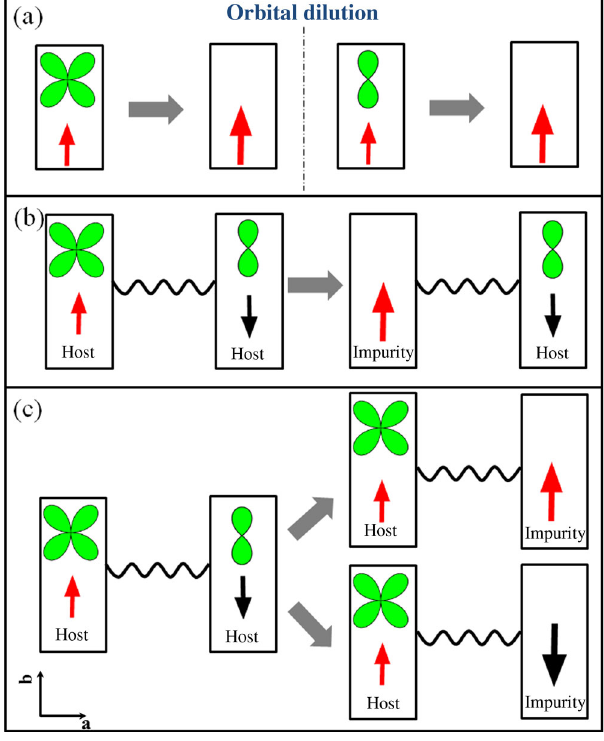
FIG. 1. (a) Schematic view of the orbital dilution when the 3 d 3 ion with no orbital degree of freedom and spin S ¼ 3 = 2 substitutes the 4 d 4 one with spin S ¼ 1 on a bond having specific spin and orbital character in the host (gray arrows). Spins are shown by red arrows, and doubly occupied t 2 orbitals (doublons) g are shown by green symbols for the a and c orbitals, respectively. (b) If an inactive orbital along the bond is removed by doping, the total spin exchange is AF. (c) On the contrary, active orbitals at the host site can lead to either FM (top) or AF (bottom) exchange coupling, depending on the energy-level mismatch and difference in the Coulomb couplings between the impurity and the host. We show the case when the host site is unchanged in the doping